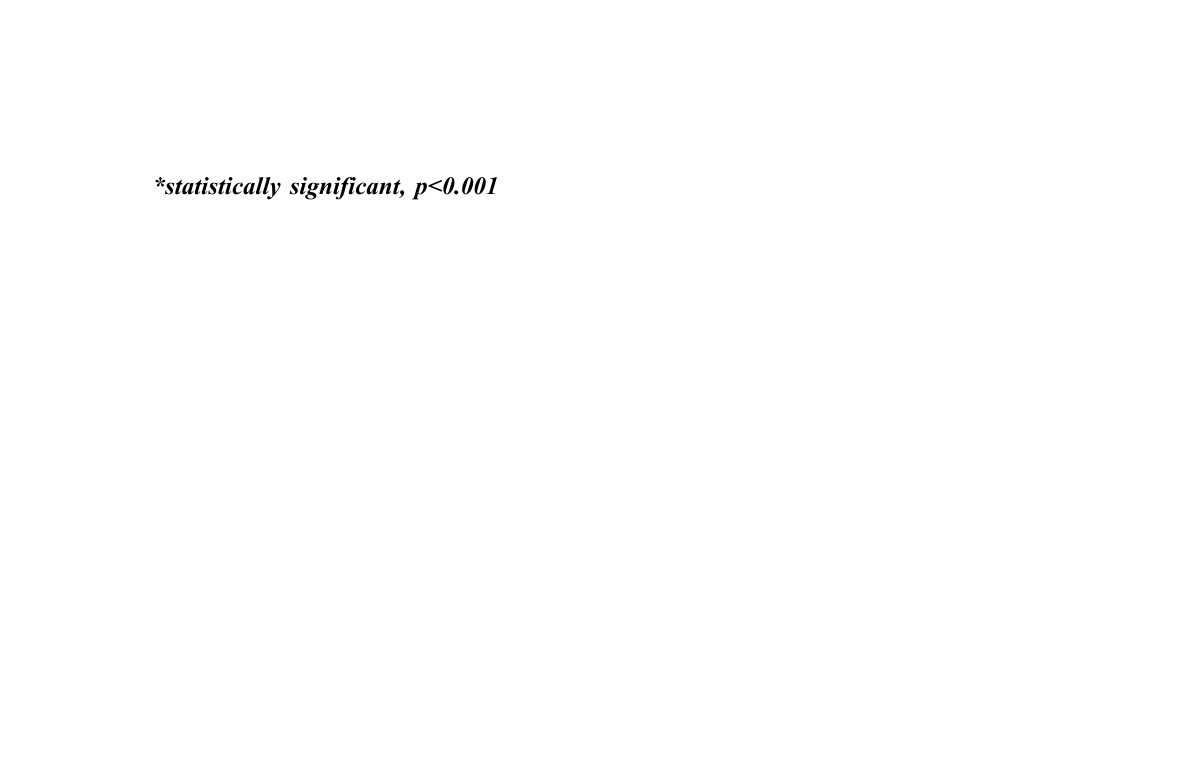
Table I : Serum Cu and Zn levels in cancer patients (n=52)